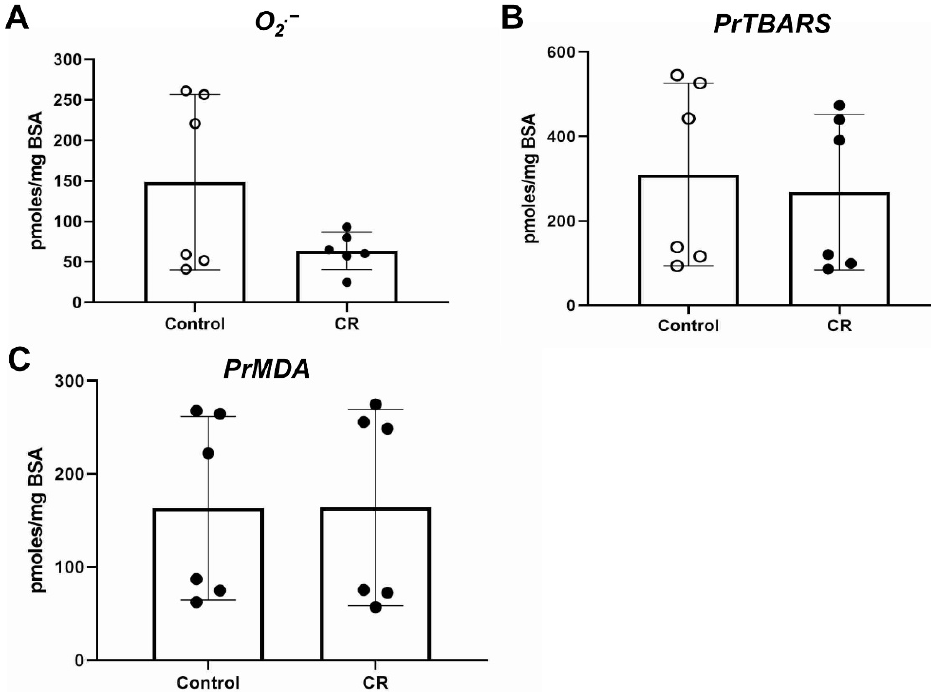
Figure 4. OS assessment in wild ‐ type embryonic livers: ( A ) superoxide radical (O 2• − ); ( B ) PrTBARS (protein bound thiobarbituric (TBA) reactive (lipoaldehydic) substances; ( C ) PrMDA (malondialde ‐ hyde (MDA) bound to total proteins). * p < 0.05. Control: fed ad libitum; CR: calorie restriction. No significant difference was found in either O2 • − , PrTBARS or PrMDA in the livers of the WT mothers (Figure 5).